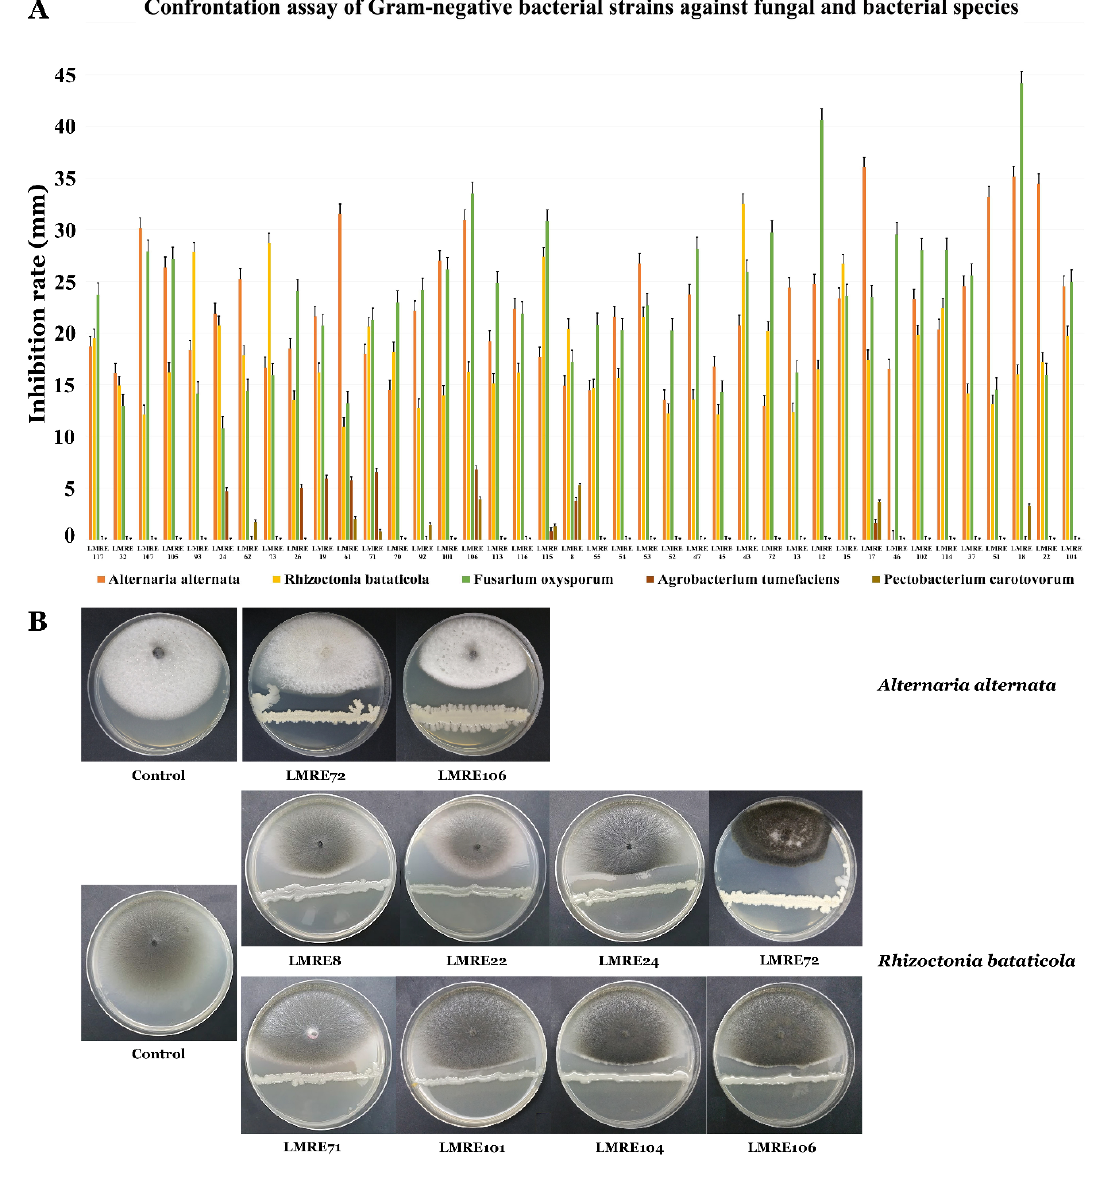
Figure 7. (A) Bar-chart of confrontation assay of Gram-negative bacterial isolates against fungal strains and bacterial isolates. (B) Confrontation test of Rhizoctonia bataticola against bacteria. and bacterial isolates. ( B ) Confrontation test of Rhizoctonia bataticola against